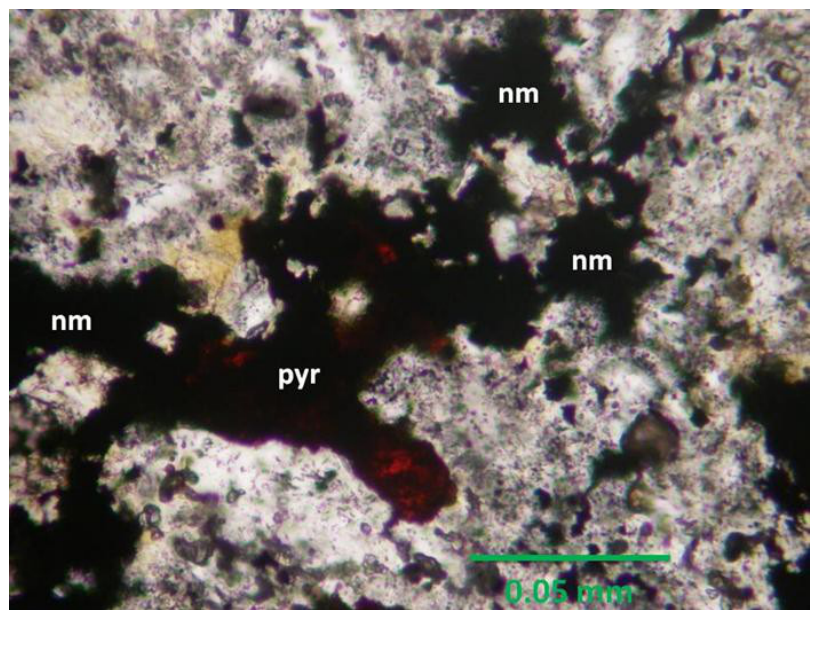
Figure 8. Photomicrograph of a portion of one of the naumannite (nm) dendrites shown in Figure 6, where pyrargyrite (pyr, red) locally composes part of the dendrite (transmitted light, polars not